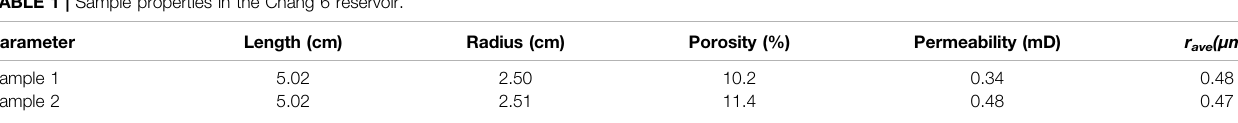
TABLE 1 | Sample properties in the Chang 6